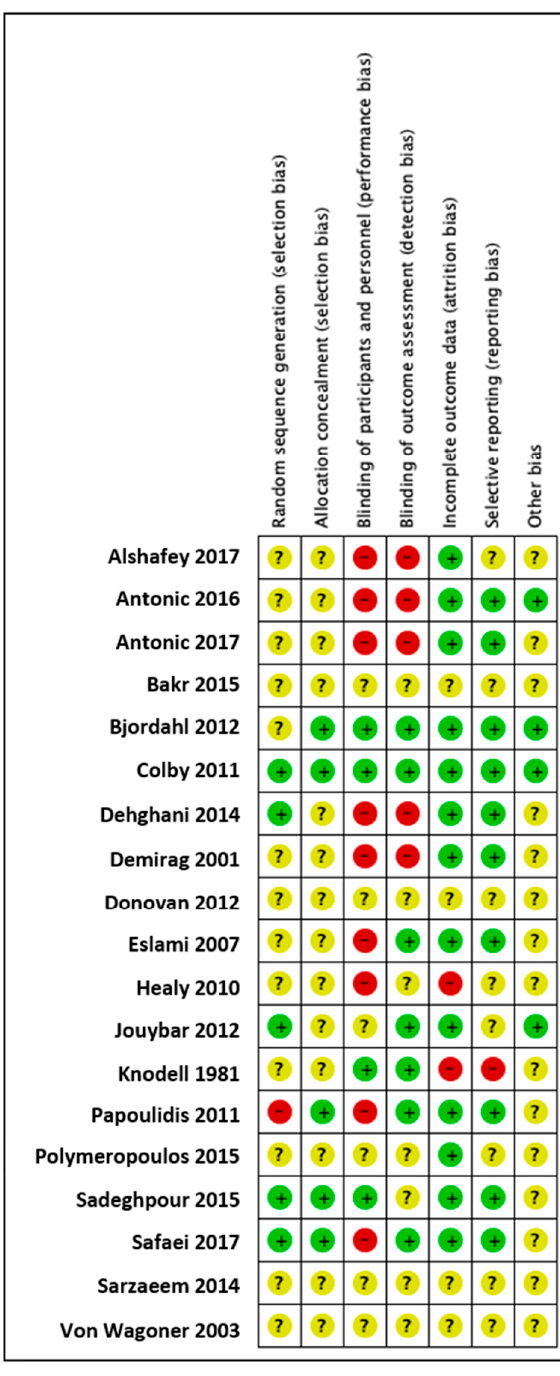
Figure 2. Risk of bias summary.